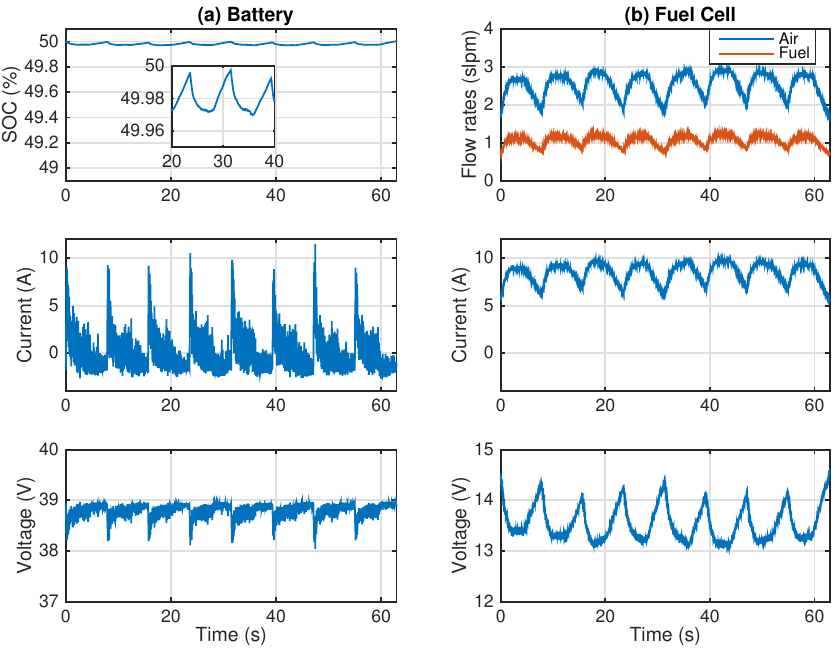
Figure 26. Medium-SOC full-active hybrid simulation. ( a ) Battery response and ( b ) FC response.